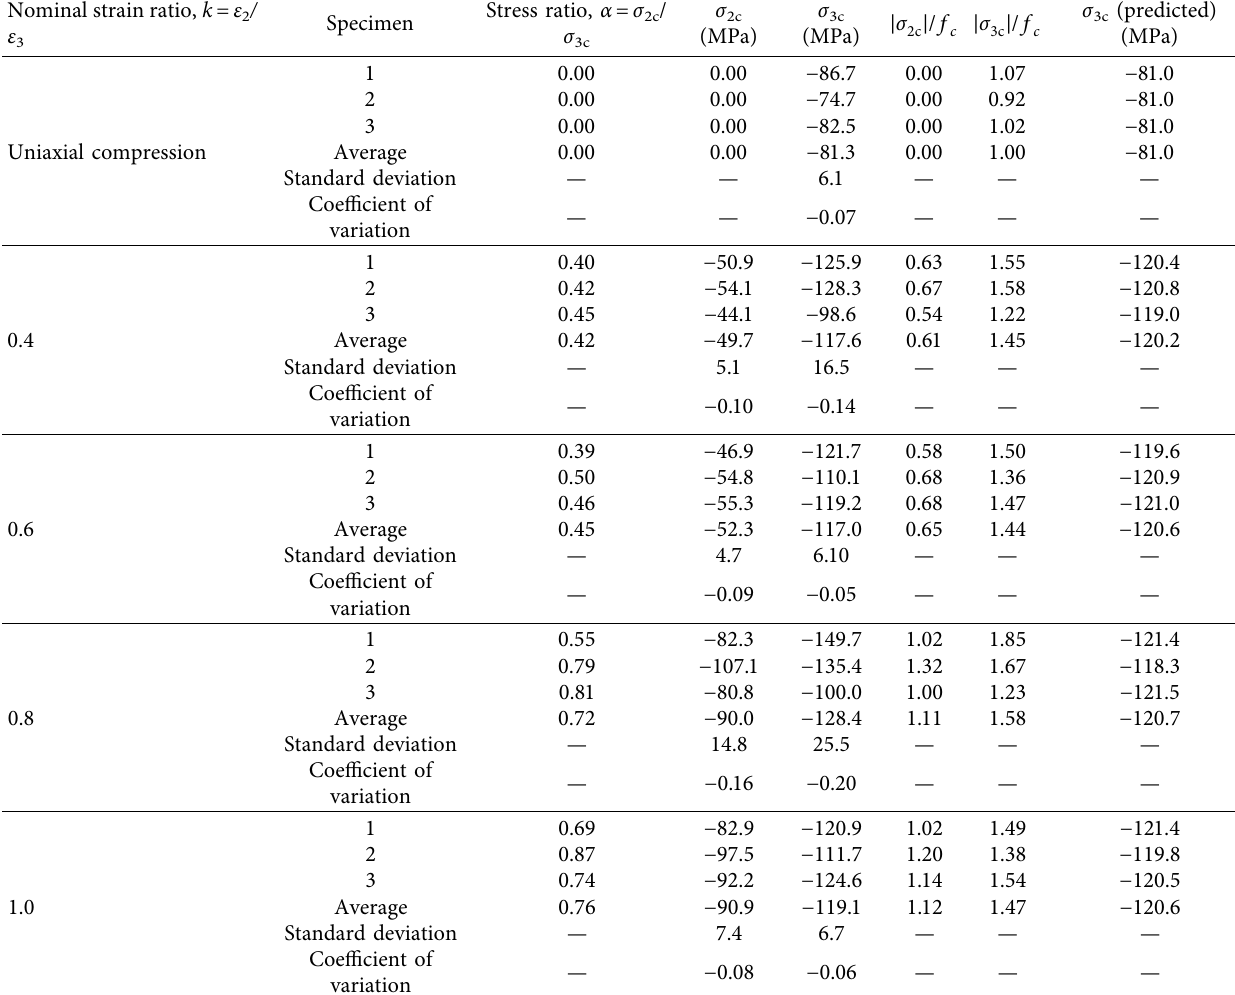
Table 3: Strength of RPC specimens under